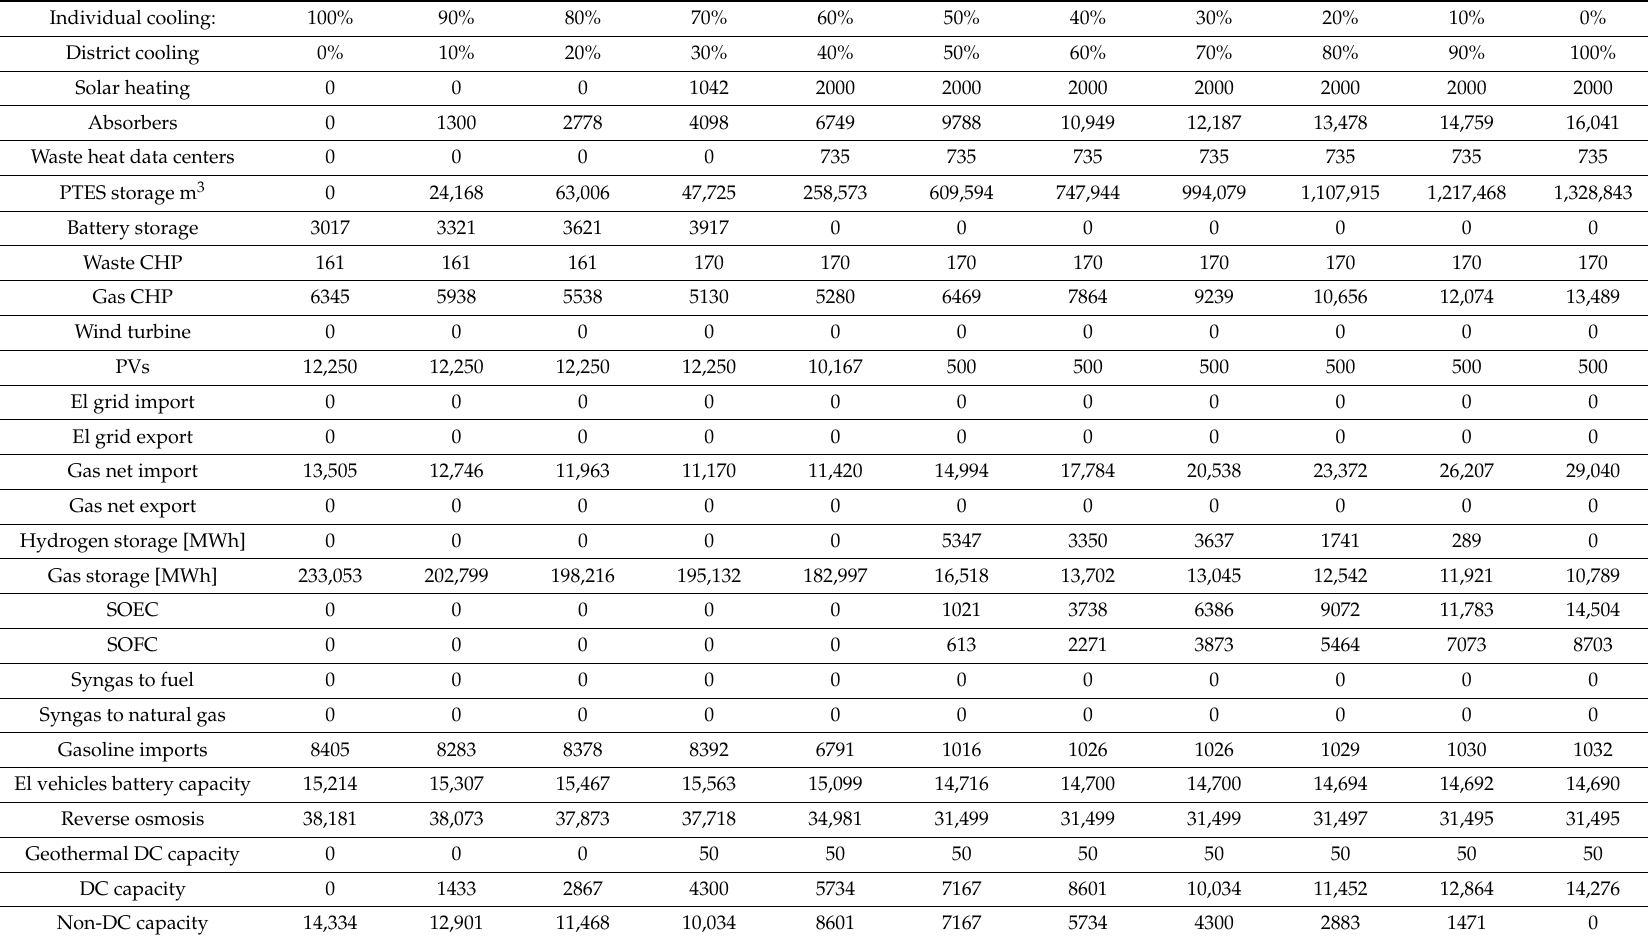
Table A1. Optimal capacities of technologies in PV constrained scenario